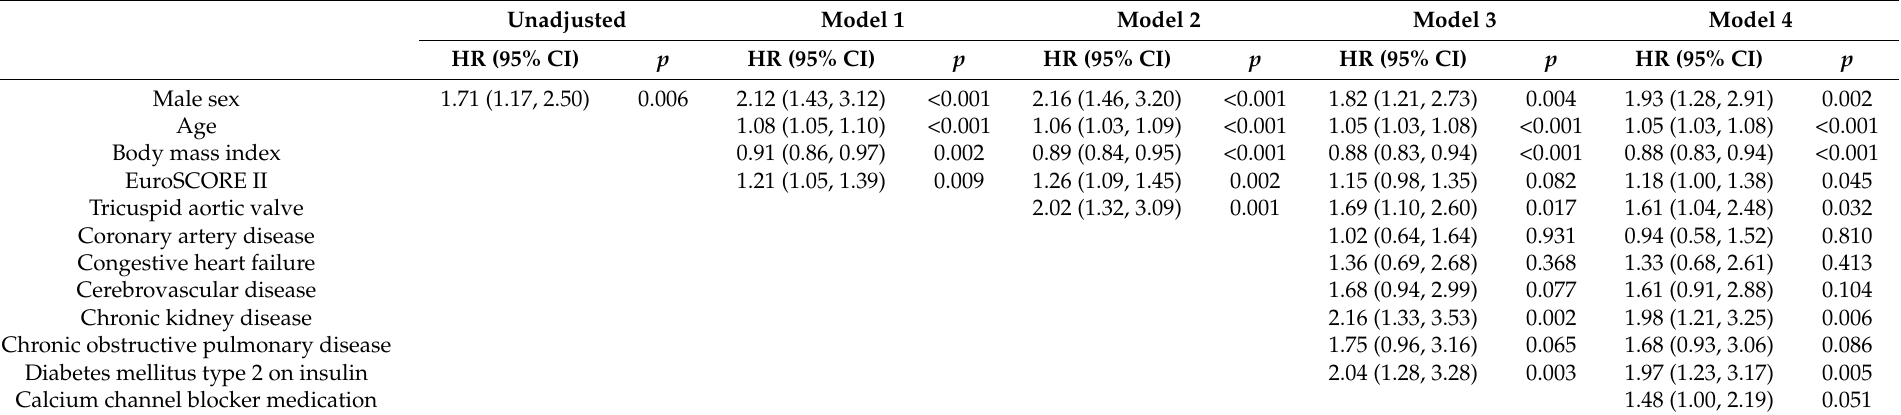
Table 3. Uni and multivariate Cox regression analyses of the effects of male sex on long-term mortality